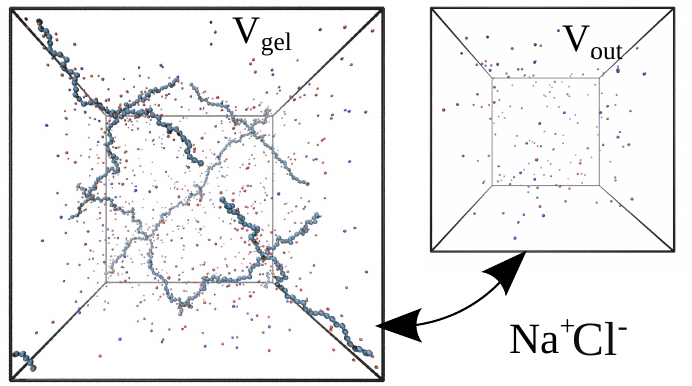
Figure 4. Diamond-like network in the simulation box. Red and blue particles are the ions Na + and Cl −